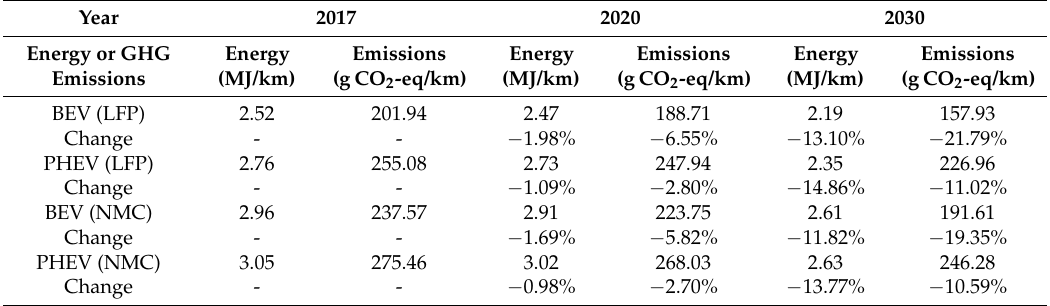
Table 10. The life cycle energy consumptions and GHG emissions in the 2020 and 2030